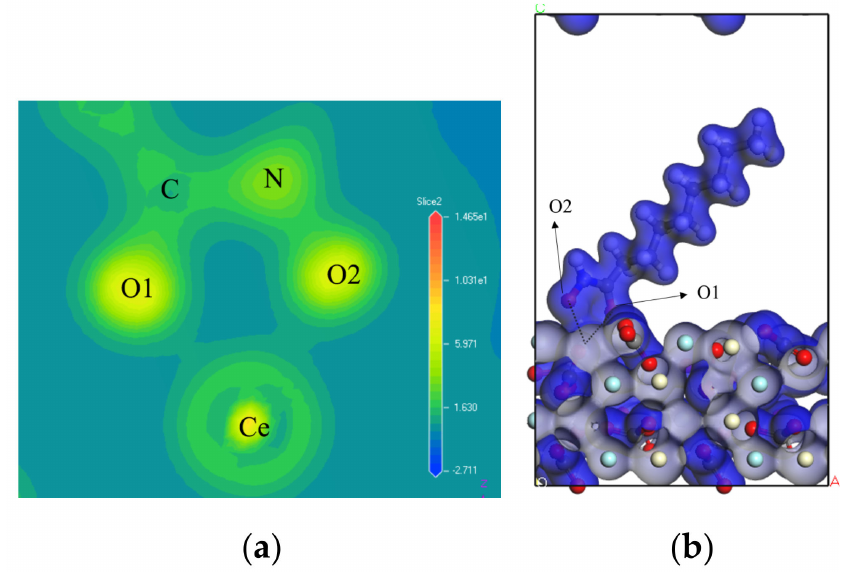
Figure 5. ( a ) is the charge density of NHA adsorbed between O-Ce atoms on bastnaesite (100) surface, ( b ) is the charge equivalent surface of NHA adsorbed on the bastnaesite (100) surface. 3.2. Effect of the Substitution of Ce with La on the Adsorption of NHA on the Bastnaesite (100)